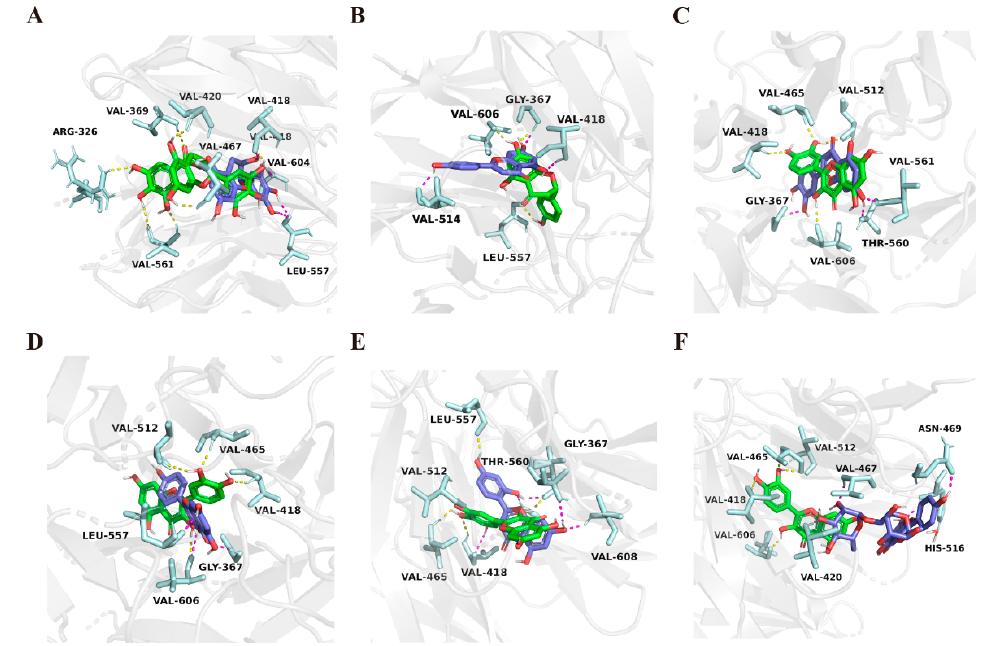
Figure 2. EGCG (( A ) in green), EGC (( A ) in purple), Naringenin (( B ) in green), Apigenin (( B ) in purple), Quercetin (( C – F ) in green), Luteolin (( C ) in purple), Kaempferol (( D ) in purple), Morin (( E ) in purple), and Rutin (( F ) in purple) in the binding site of Keap1–Nrf2 complex. (PDB ID: 2FLU). The figure was generated using PyMol (http://pymol.sourceforge.net/) (accessed on 5 July 2022).